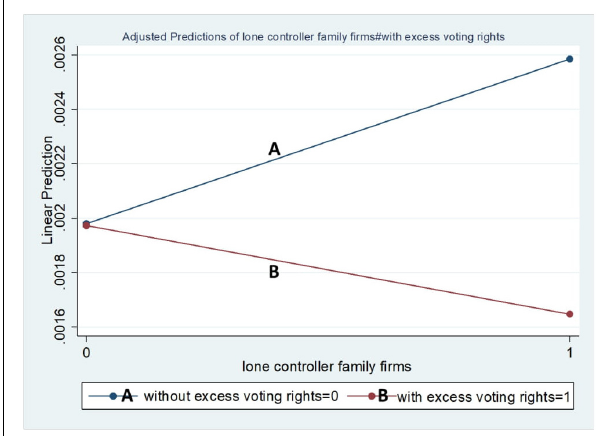
FIGURE 1 | Moderating effect of voting rights on LCFF-R&D investment.